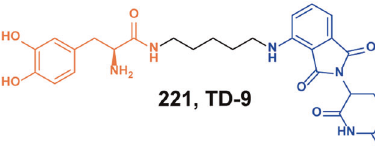
Fig. 72 The representative PROTAC targeting